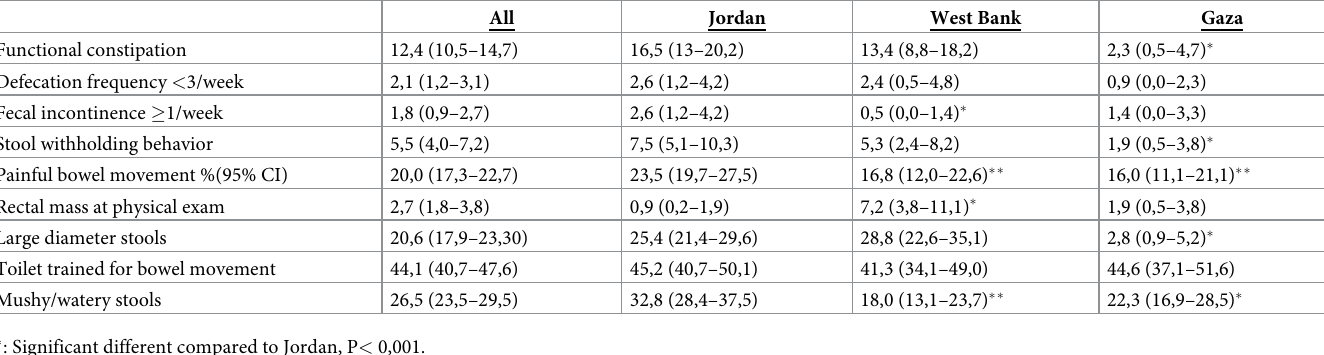
Table 1 depicts the prevalence of FC and the occurrence of each ROME III criteria per loca- tion. The prevalence of constipation was significantly lower in Gaza compared to Jordan and the West Bank (2% vs. 17% and 13%, respectively, p < 0.001). No significant difference was found in prevalence of constipation between the different age groups (Fig 1). Table 2 depicts the demographic, social-economic variables, stress related variables and traumatic exposure among the three locations. Mothers and their children from the West Bank and Gaza experienced more domestic violence compared to mothers and children living in Jordan. Significantly more mothers in Gaza were forced to move to another house because of security reasons compared to Jordan. Additionally, the median trauma score was signifi- cantly higher in Gaza compared to Jordan. The proportion of moderate and high trauma scores was also higher in Gaza compared to Jordan. Multiple regression analysis showed that living in Gaza is related to lower odds for having FC (p < 0,001, OR 0,05, 95% CI 0,02–0,18). Higher odds for FC was seen in families who had an income that did not meet the essential needs (p = 0,002, OR 2,45, 95% CI 1,39–4,31). Other demographic-, social- or economic-, and stress related factors were not significantly predictive or protective for FC. (Table 3)